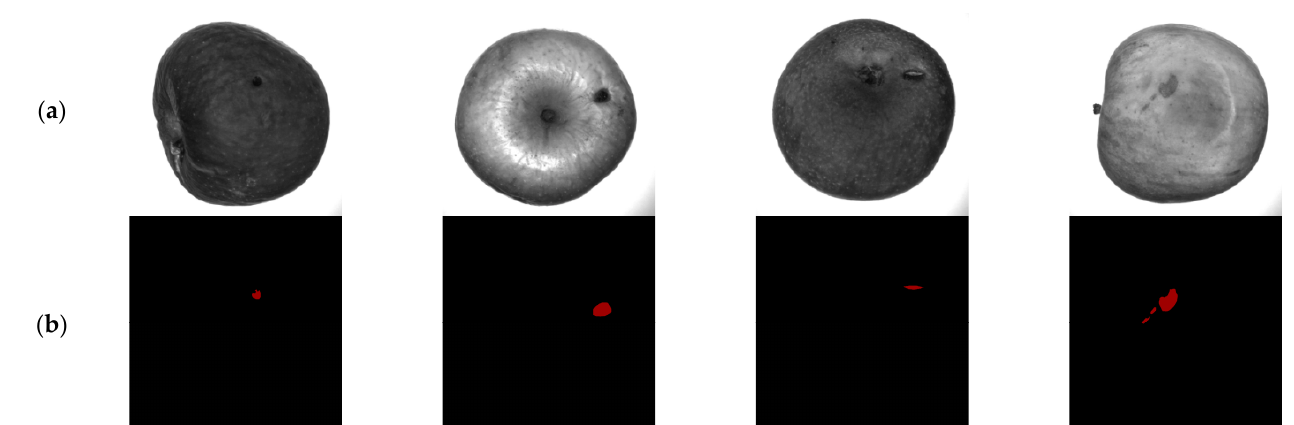
Figure 3. Part of the apple images and the corresponding labels. ( a ) image ( b ) label.